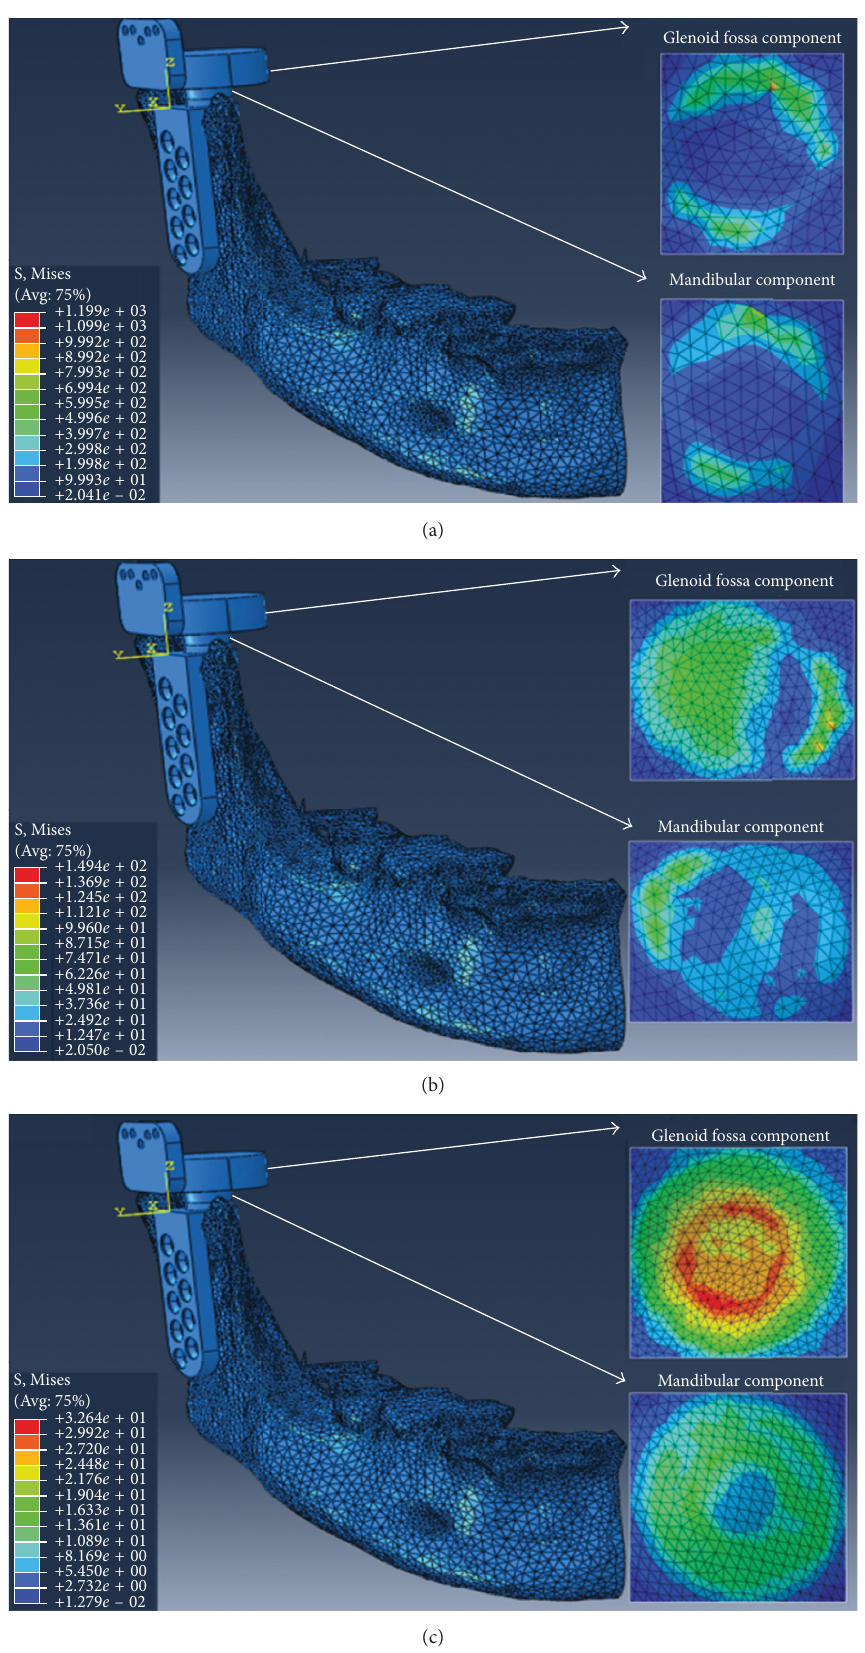
Figure 7: Contour of Mises contact stresses within the contact interface at the glenoid fossa and mandibular components for (a) cases 1, (b) 2, and (c) 3 included in Tables 1 and